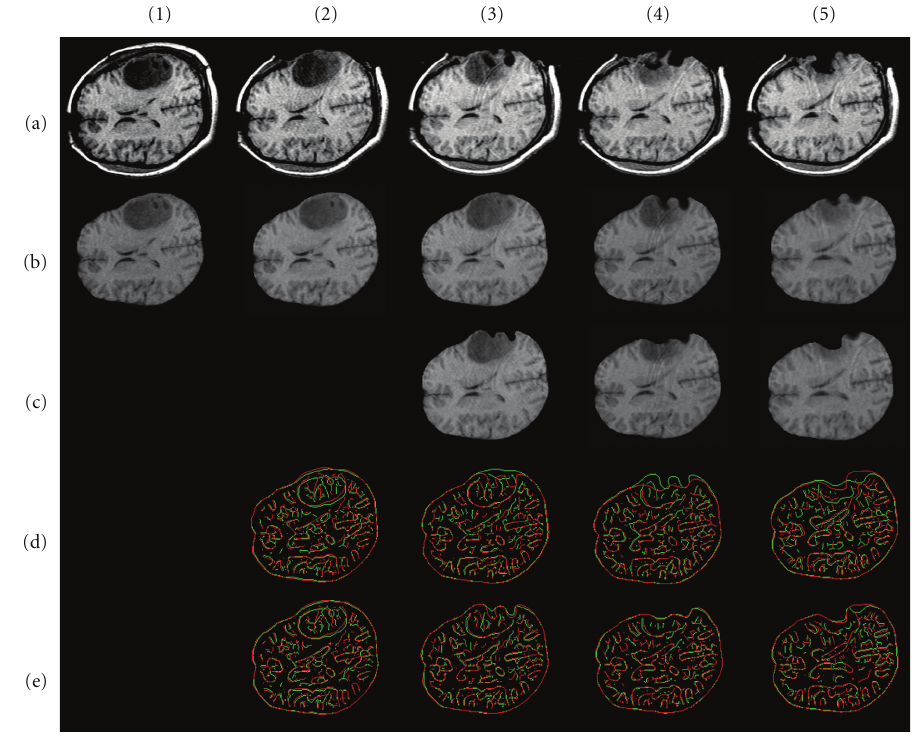
Figure 6: Second patient case. (a) Sequence of five input iMR images rigidly registered to the first one. (1b) Whole-brain region extracted from (1a). (2b) Deformation of (1b) computed using FEM for brain shift modeling. (3b) Deformation of whole-brain region extracted from (2a) computed using FEM for 1st resection modeling. (3c) Masking of (3b) with whole-brain region segmented from the 3rd iMR image (3a). (4b) Deformation of whole-brain region extracted from (3a) computed using XFEM for 2nd resection modeling. (4c) Masking of (4b) with whole-brain region segmented from 4th iMR image (4a). (5b) Deformation of whole-brain region extracted from (4a) computed using XFEM for 3rd resection modeling. (5c) Masking of (5b) with whole-brain region segmented from 5th iMR image (5a). (d) Juxtaposition of Canny edges of images rigidly registered. The edges of the first (second) image of the pair under consideration are in green (red). (e) Ditto for (d) when images are nonrigidly